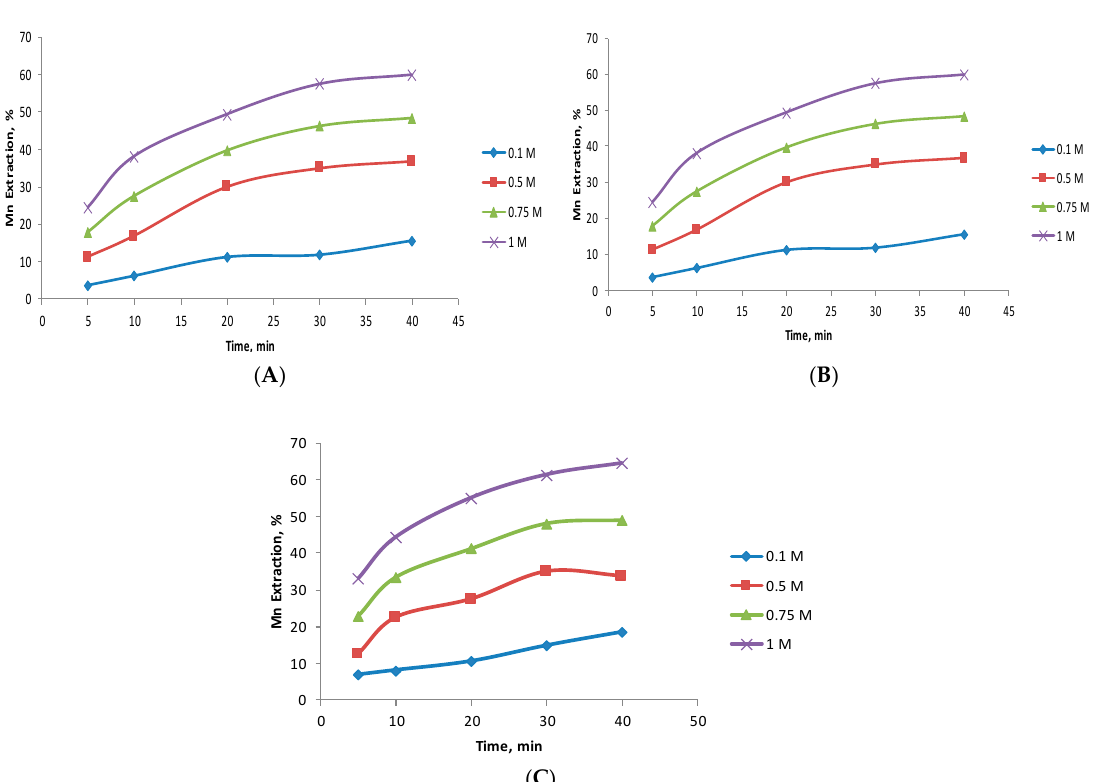
Figure 11. Effect of particle size (manganese nodule) on Mn extraction (25 ◦ C, H 2 SO 4 : 0.1, 0.5, 0.75, 1 M). ( A ): − 100 + 140 Tyler mesh ( − 150 + 106 µ m), ( B ): − 200 + 270 Tyler mesh ( − 75 + 53 µ m), ( C ): − 320 + 400 Tyler mesh ( − 47 + 38 µ